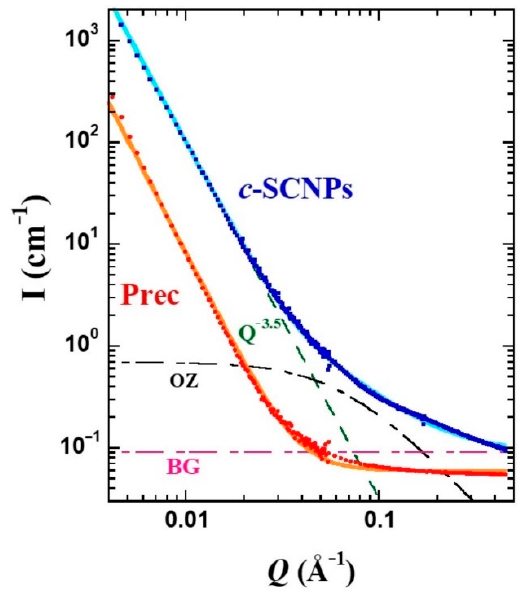
Figure 4. Differential cross section of Prec (red circles) and c -SCNPs (blue squares). The orange solid line is a description of the data for Prec at intermediate length scales, consisting of a ∝ Q − x law with x = 3.5 and a constant background. The blue solid line describes the c -SCNPs data, including an Ornstein-Zernike contribution (black dashed-dotted line), a ∝ Q − x law with x = 3.5 (green dashed line) and a constant background (pink dashed-dotted line).